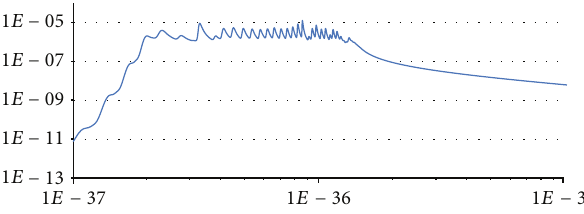
Figure 2: The Hubble parameter throughout the inflationary period (log-log